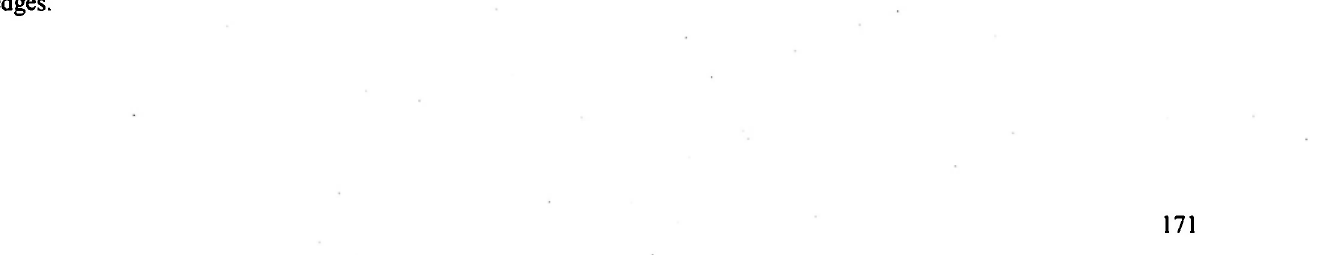
Fig. 8: Load-deflection curves obtained from ANSYS computations and testing The stress distribution of BFRP in cross-shaped strengthened slab was compared with that in 'square-collar' strengthened slab (Figs. 9 and 10). For the cross-shape strengthened method, the BFRP stresses in the central area were greatest, while the stresses were smaller towards the ends of the BFRP plate. The stresses are very uneven across the BFRP plate. Also, at the intersecting region of the cross-shape BFRP, the BFRP plates were experiencing tension in the two perpendicular directions. Therefore, the stress distribution exhibited a 'X' shape at the middle. The maximum strength of the BFRP is in the longitudinal direction. At the intersection area of the cross-shape laminate, there are two force components acting on the laminate during the loading. One component is the in-plane pulling force by laminate along the fiber direction, and the other is the out-of-plane bending acting on the diagonal axes of the slab, which is 45 degree to the cross-shape laminate. Since the out-of-plane shear strength of the laminate is very weak, which is predominated by the resin property, the out-of-plane failure would occur first at the intersection during loading. The test results indicated the premature failure due to out-of-plane shear stress and the cracks would propagate towards to the